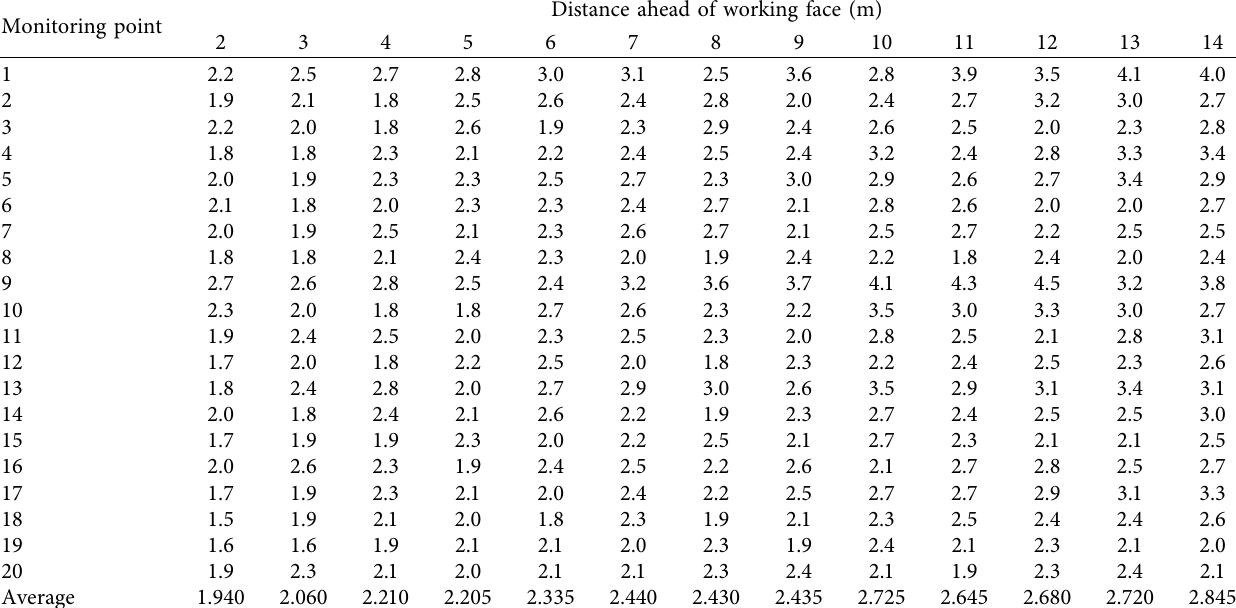
Table 2: Statistics of drilling cutting weight in Xinglongzhuang Coal Mine